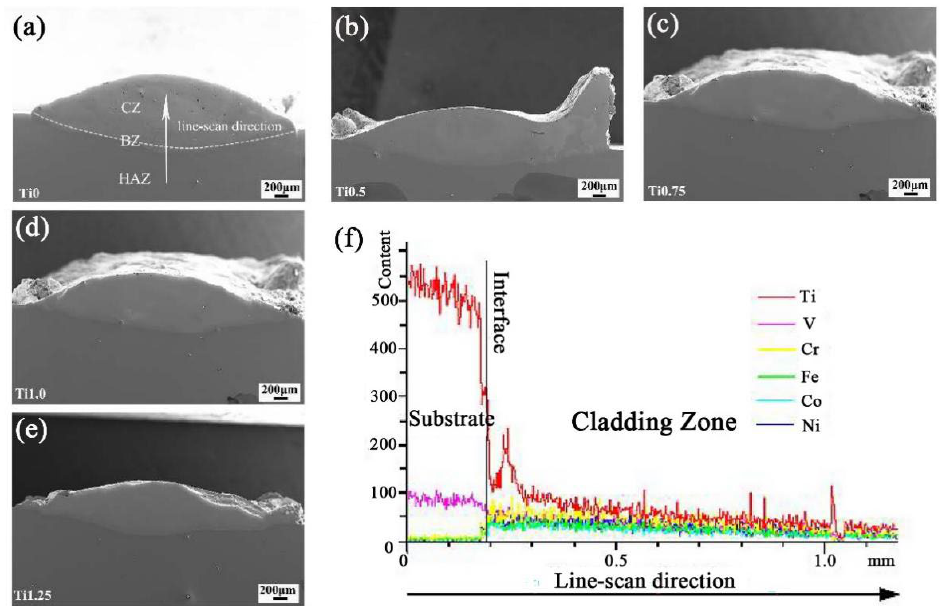
Figure 7. SEM images of the cross-section and line-scan result of the CrFeNi 2 V 0.5 Tix cladding layer with different Ti content: ( a ) Ti0; ( b ) Ti0.5; ( c ) Ti0.75; ( d ) Ti1.0; and ( e ) Ti1.25, and ( f ) line-scanning analysis results of Ti0 coatings (CZ: cladding zone; BZ: bonding zone; HAZ: heat-affected zone) [121]. Reprinted with the kind permission of MDPI.